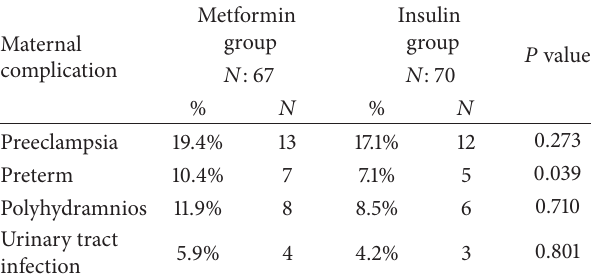
Table 3: Maternal complications in study groups.